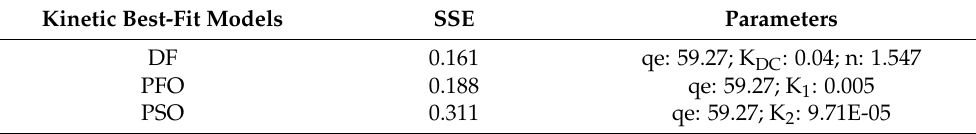
Table 7. Thermodynamic parameters for the adsorption of MB by KBS .